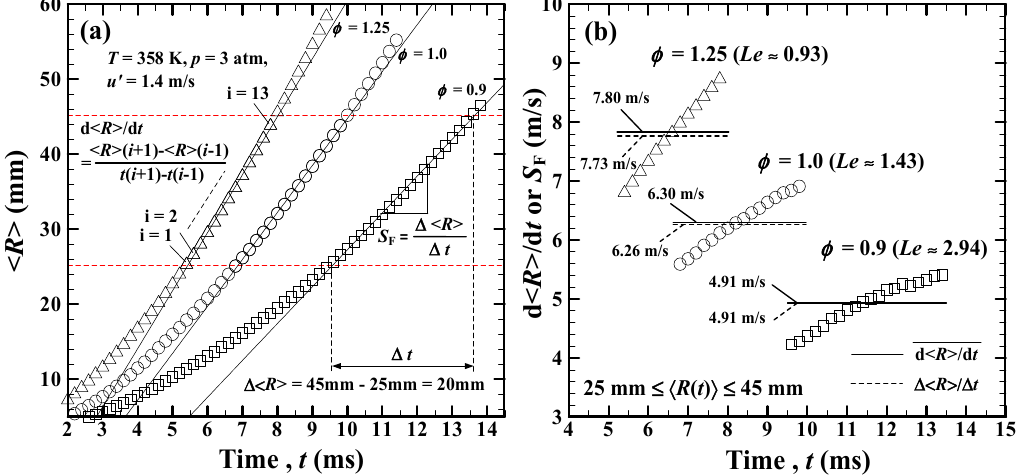
Figure 3. ( a ) Typical averaged flame radii of turbulent iso-octane/air premixed flames as a function of time at three different values of φ with Le > 1 ( φ = 0.9 and 1.0) and Le < 1 ( φ = 1.25) under the same p = 3 atm, u ′ = 1.4 m/s and T = 358 K conditions. ( b ) Two turbulent flame speeds versus time, d ⟨ R ⟩ /d t and S F (the slope of ⟨ R ⟩ ( t )) as indicated in ( a ), which are almost equal to each other within 25 mm ≤ (cid:104) R ( t ) (cid:105) ≤ 45 mm.